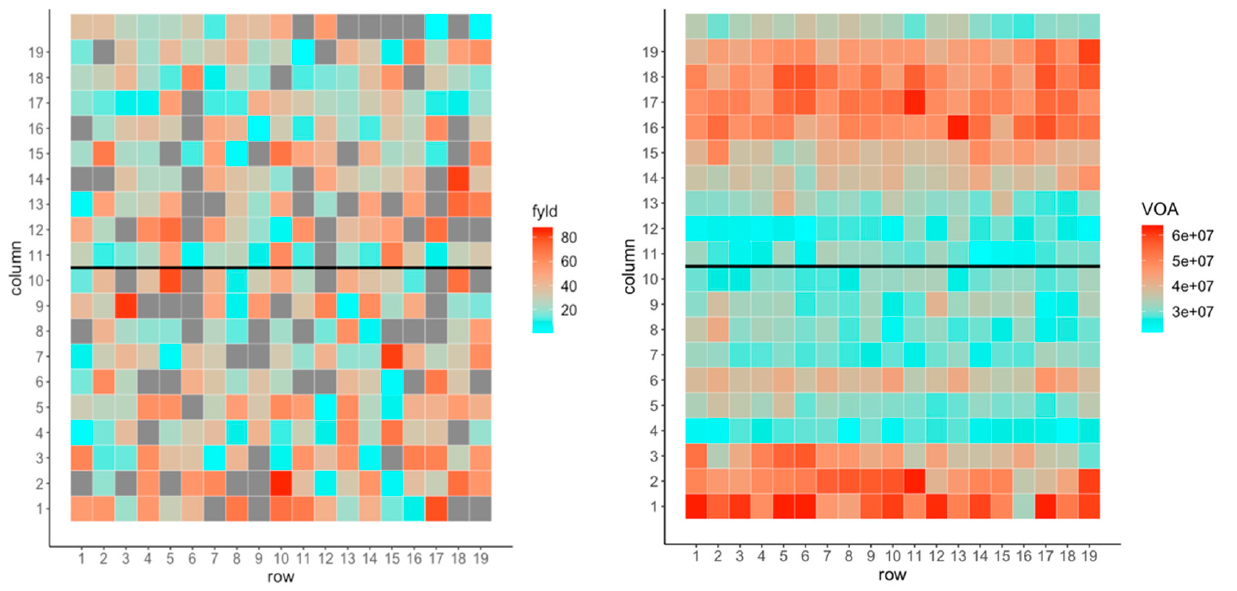
Figure 11. Heatmap showing the distribution of fyld ( left ) and the raw values of VOA ( right ) throughout replications.